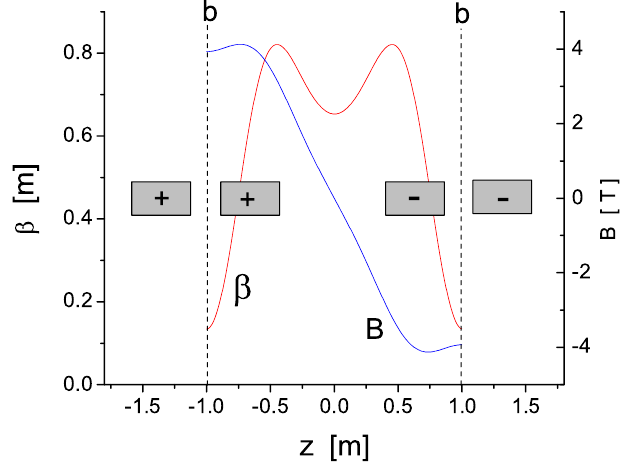
FIG. 12. (Color) An example of a h(cid:8) (cid:1) j (cid:1) (cid:8)i